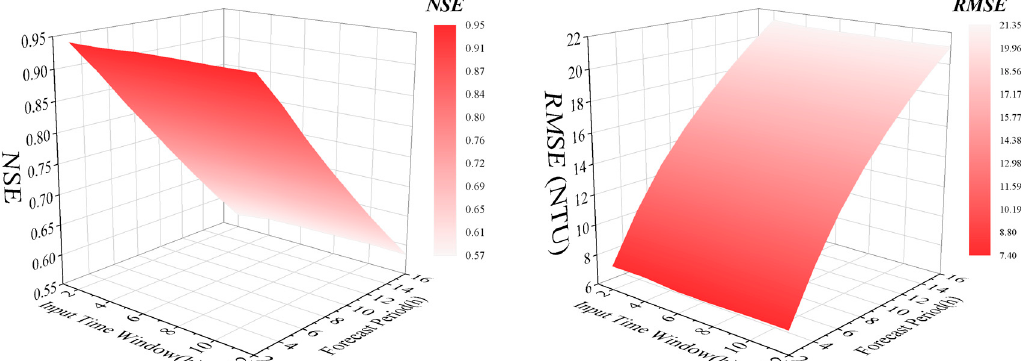
Figure 5. ( Left ) NSE and ( right ) RMSE of S2-data-based LSTM model with different input time windows and forecast periods without future wind speed as an additional input variable.